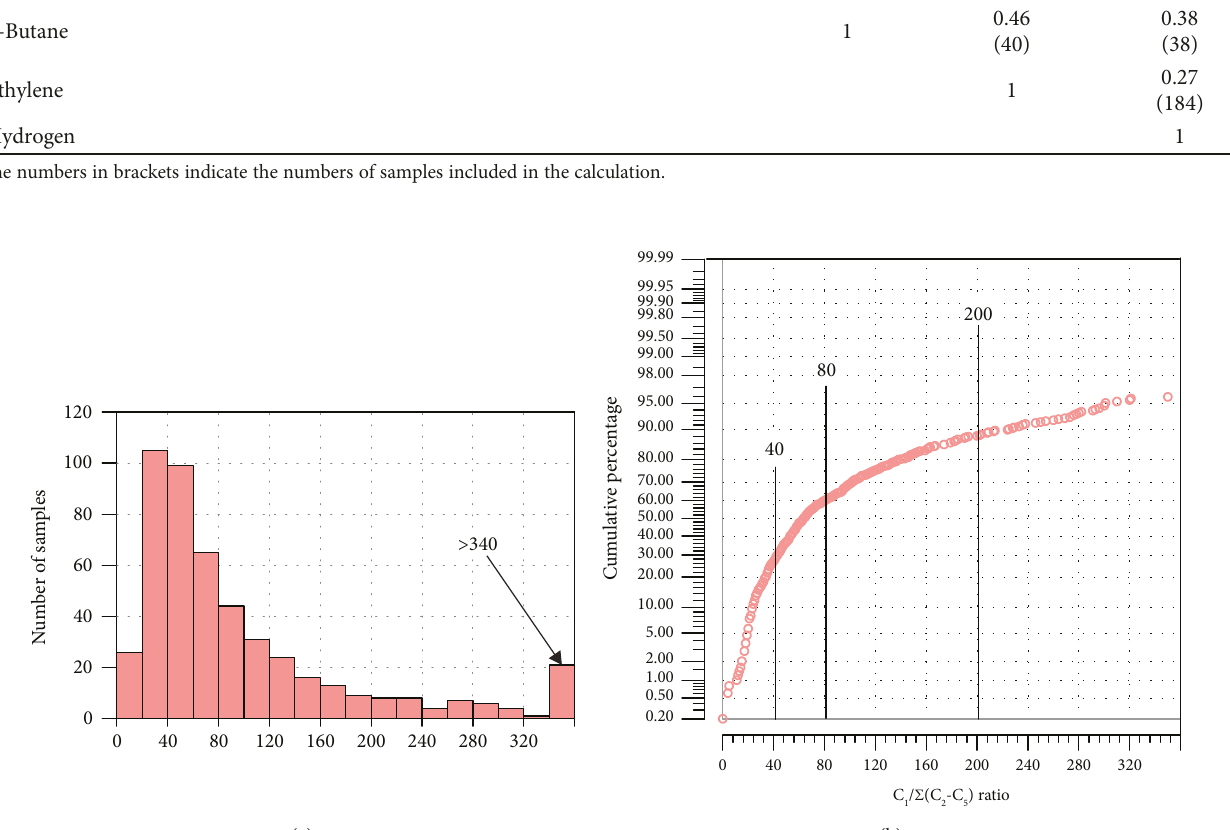
/ Σ (C -C ) ratios calculated for analyzed soil gas 1 2 5